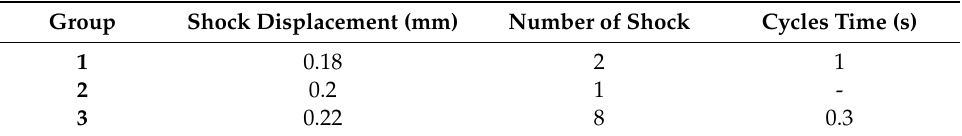
Figure 4. ( a ) Equivalent input estimation of the MEMS resonant accelerometer under some disturbances, ( b ) detailed view of the drastic disturbance at approximately 600th sample point, ( c ) detailed view of slowly-varying disturbance in the range between 200th and 350th sample points, ( d ) adaptive window-length variance of the proposed filter under static condition. Table 2. Characteristic of multi disturbances in static Table 3. Variance of equivalent input estimation under static condition with multi disturbances.